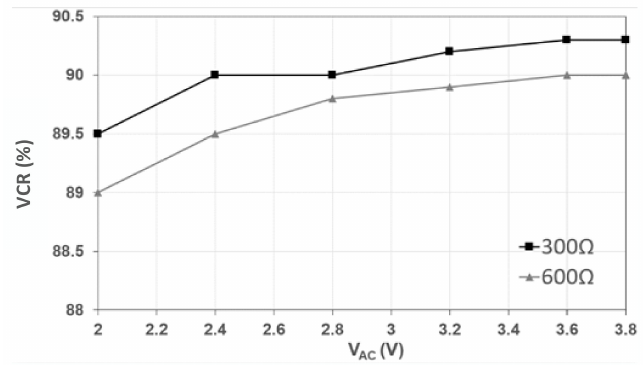
Figure 15. Measured VCR under different input voltage.